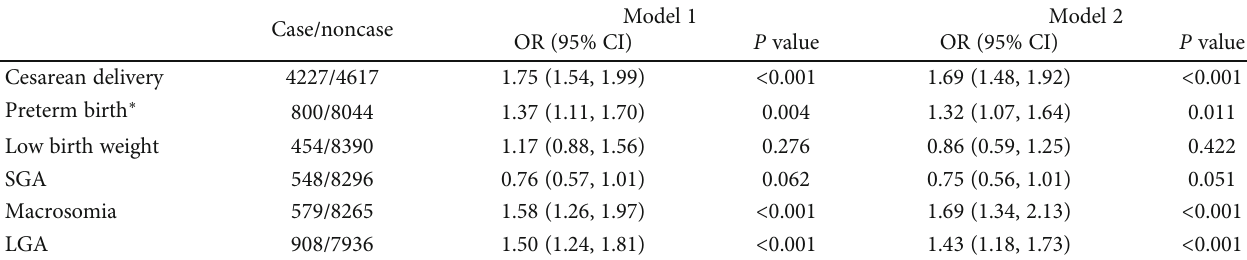
Table 2: ORs (95% CIs) for pregnancy outcomes by gestational diabetes